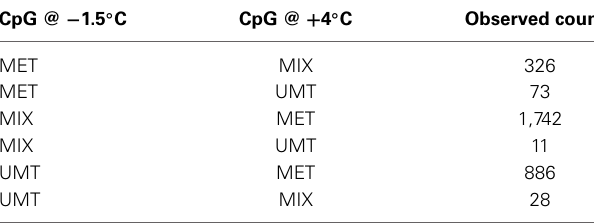
Table 2 | Directional methylation